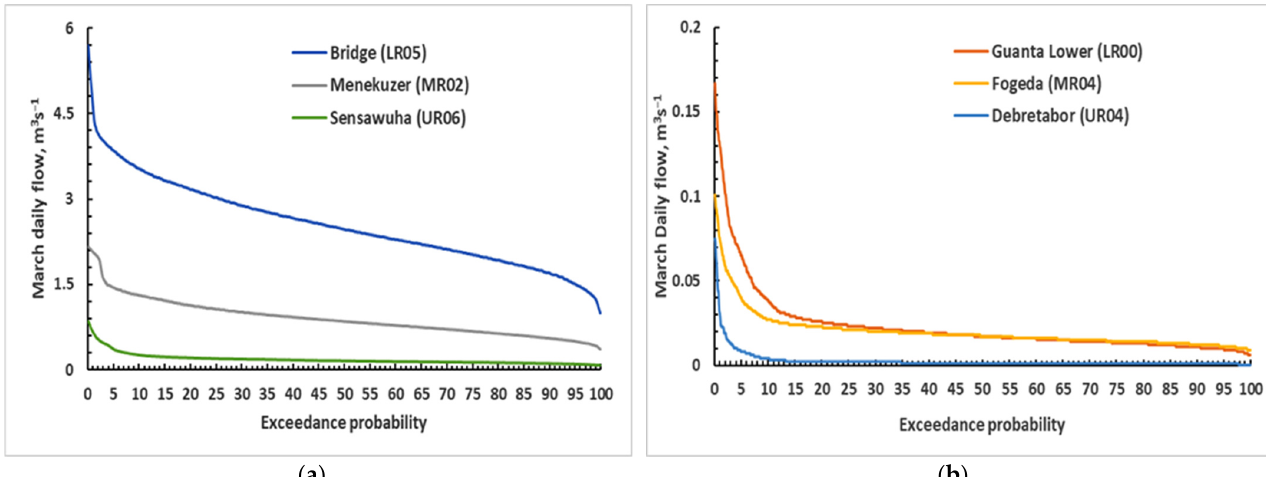
Figure 3. Flow duration curve for the month of March. ( a ) Higher river orders of the Gumara bridge site (LR05) in the lower reach, Menekuzer site (MR02) and Sensawuha site (UR06) in the upper reach; ( b ) lower river orders of Guanta lower site (LR00) in the lower reach, Fogeda site (MR04) in the middle reach and Debretabor site (UR04) in the upper reach. The flow duration for other sites is generated likewise to extract the 80th-percentile flow (Q80) as the threshold for low flow and moderate to high flow separation. LR—lower reach, MR—middle reach, and UR—upper reach .